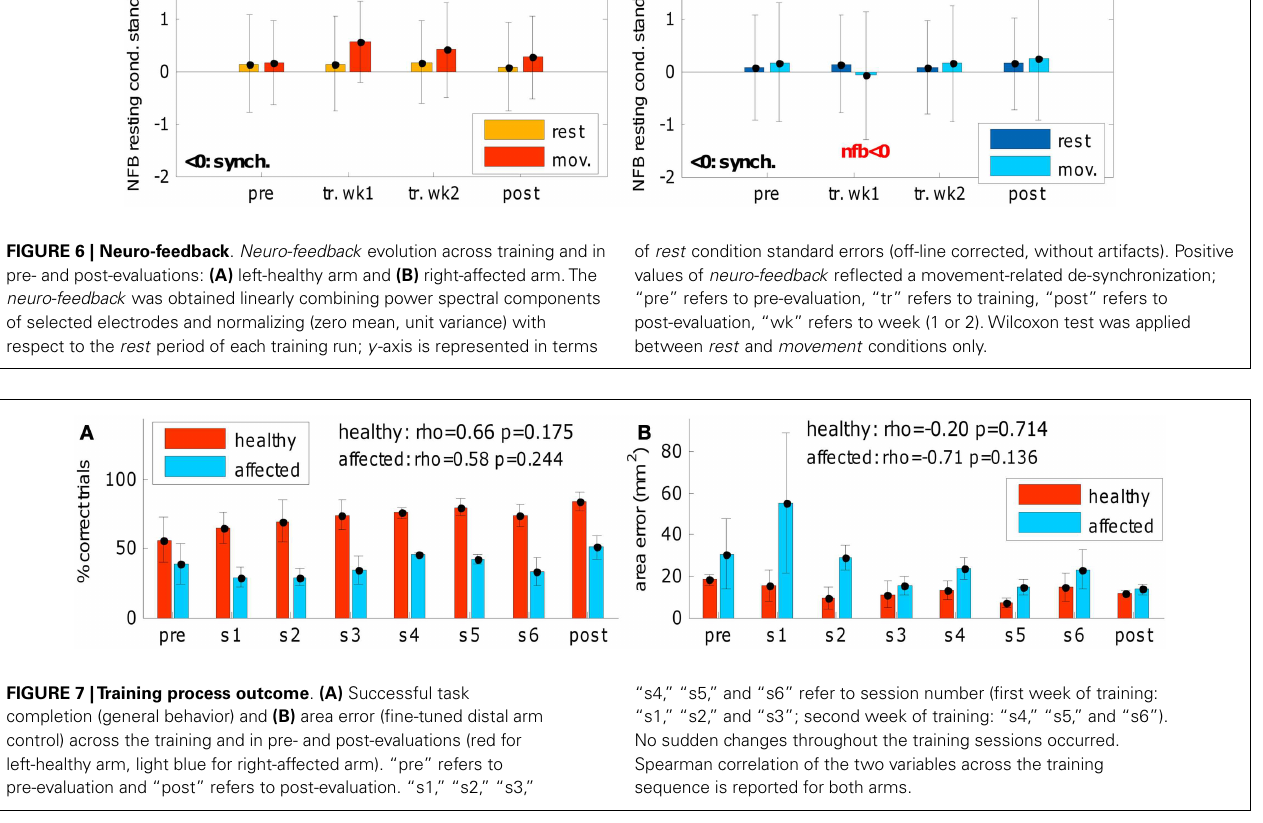
FIGURE 7 |Training process outcome . (A) Successful task completion (general behavior) and (B) area error (fine-tuned distal arm control) across the training and in pre- and post-evaluations (red for left-healthy arm, light blue for right-affected arm). “pre” refers to pre-evaluation and “post” refers to post-evaluation. “s1,” “s2,” “s3,”